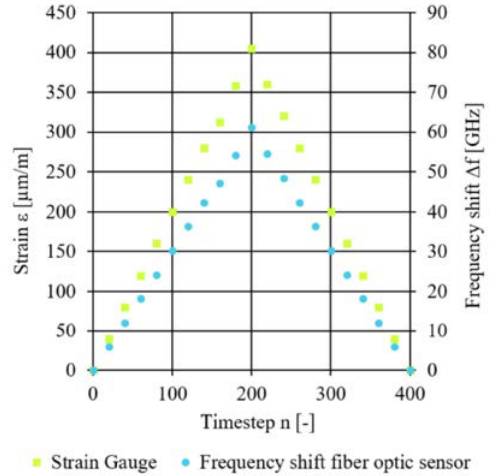
The cyanoacrylate adhesive applied, Weiss Chemie (2016), generates a stiff, and elastic connection between glass surface and fiber optic sensor. The difference in displacement between glass fiber and the adhesive matrix is insignificant, with an expected expansion spectrum of around 500 µm/m. In cyclical, path-controlled tensile tests with a rate of 0.01 mm/min and a maximum load up to strains of 405 µm/m, compressive stresses in the fiber in the range of 4 µm/m remain even after relieving due to the irreversible slip between fiber coating and adhesive down to 6 µm/m. Using linear flaw distribution in the expansion spectrum, this corresponds to a deviation of approximately 1.5